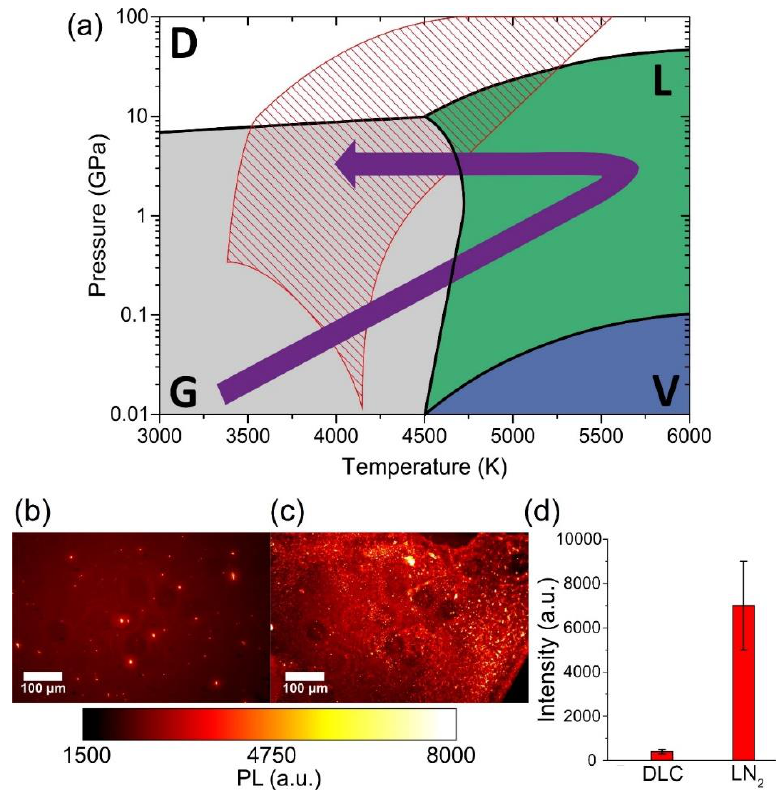
Figure 9. ( a ) Carbon phase diagram. Stability regions of diamond (D), graphite (G), vapor (V), and liquid carbon (L) are indicated, respectively, in white, grey, blue, and green. The purple arrow shows the graphite–liquid–diamond transition used to explain ND formation under pulsed laser irradiation of graphite in LN 2 . The tilted red lines show the region known as “diamond-like liquid” [33], where undercooled liquid carbon and metastable diamond coexist. Typical PL wide-field images of NDs synthesized by Pulsed Laser Deposition (PLD) in nitrogen atmosphere ( b ) and by PLA in liquid nitrogen ( c ). ( d ) PL strength comparison between the two samples, obtained by integrating the intensity of the whole PL image after background subtraction: LN 2 -NDs show a more than 10 × higher emission compared to Diamond-like Carbon (DLC)-embedded NDs. The error bars of ( d ) are given by the standard deviation of the di ff erent integrated images. Reproduced with permission from [65], Elsevier, 2019.